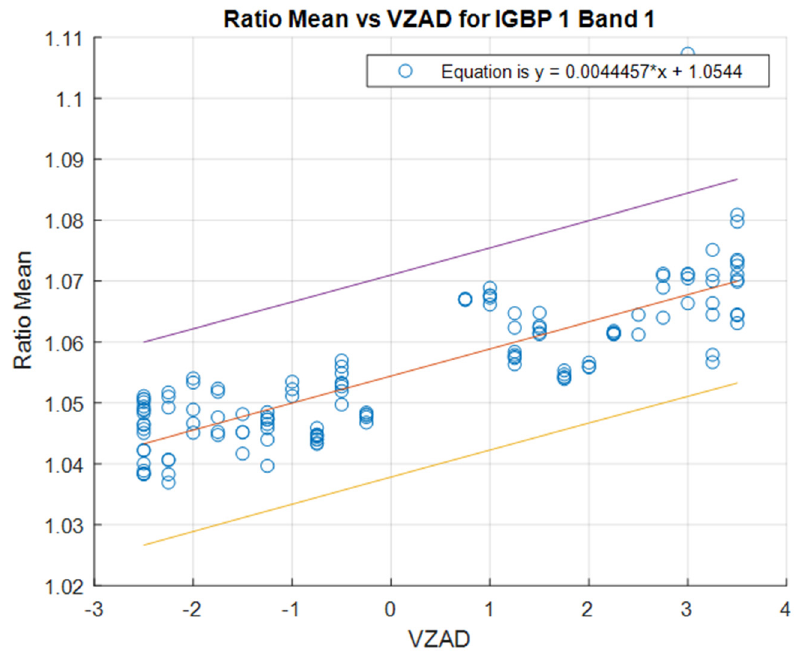
Figure 8. Reflectance ratio mean vs. view zenith angle